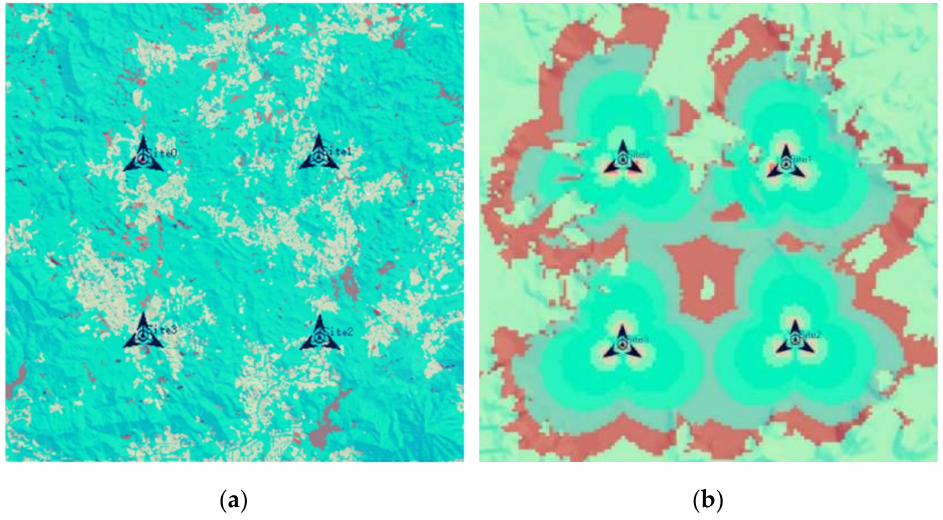
Figure 3. Simulation environment. ( a ) 5G communication test network; ( b ) 5G communication network signal